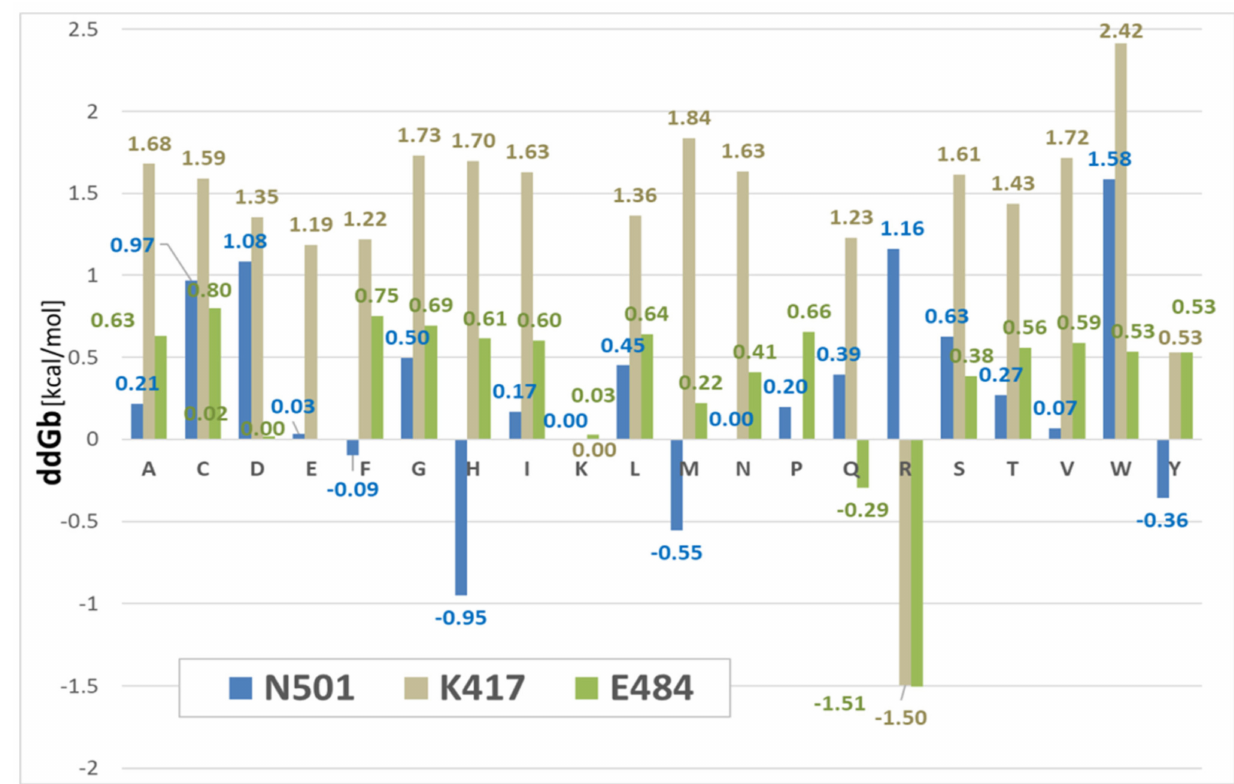
Figure 5. Calculated changes in the free-energy of binding [dG bind ] between the SARS-CoV-2 RBD and the human ACE2 receptor for the PDB 6LZG complex. The calculations were performed for 20 amino acid substitutions (single-letter residue labels in the graphic) at the three specific mutation loci indicated, including: N501, K417, and E484. Interestingly, a N501H and N501M mutations resulted in enhancement of RBD-ACE2 binding that exceeded that of the known Alpha mutant form